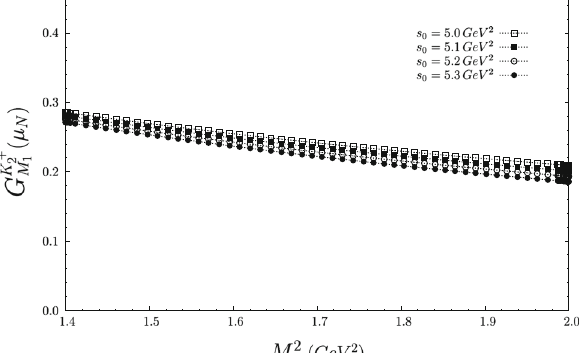
Fig. 1 Dependence of the magnetic dipole moment of the negative parity K + tensor meson, on Borel mass square M 2 , at several fixed 2 values of the continuum threshold, in units of Nuclear Magneton μ N